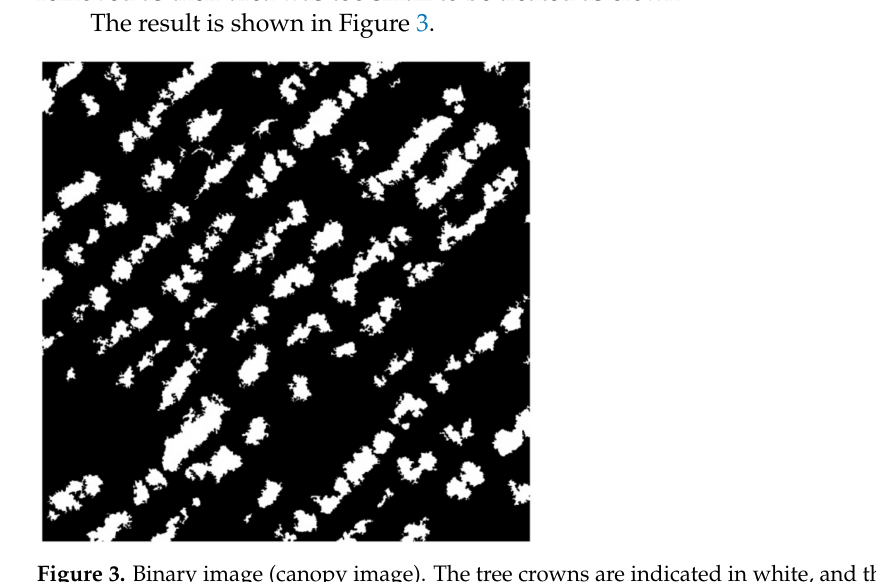
Figure 3. Binary image (canopy image). The tree crowns are indicated in white, and the background is indicated in